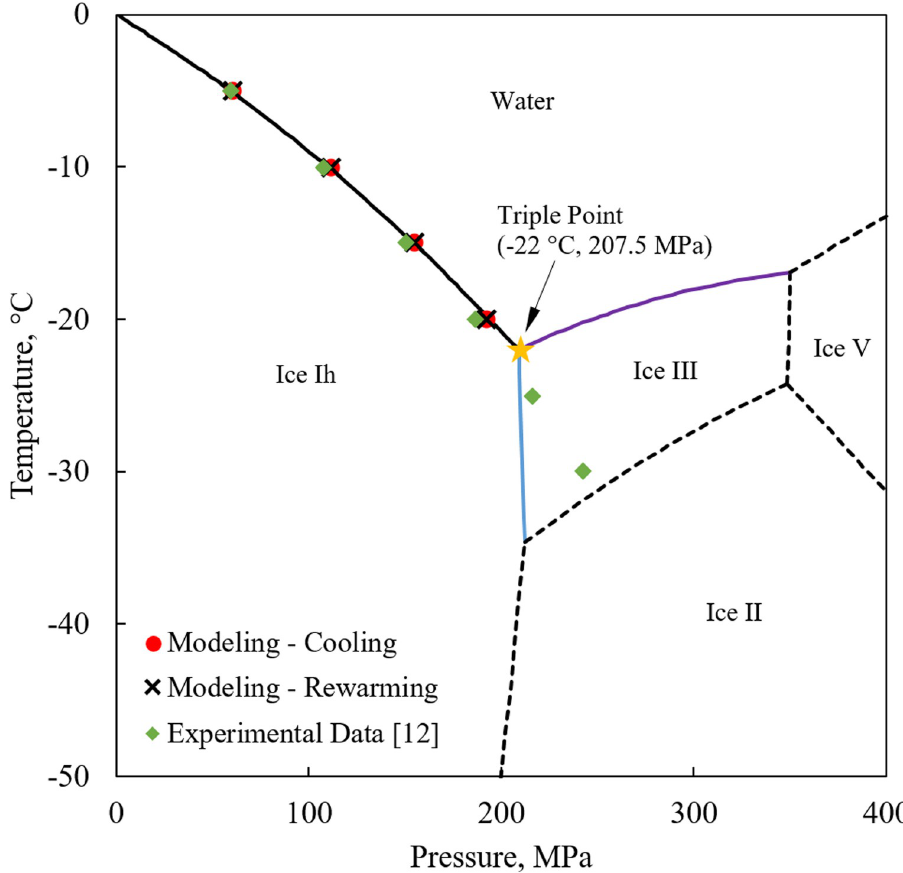
Fig 1. Water phase diagram. Phase diagram of water in temperature and pressure ranges relevant to the current study, as compiled from [11]. Also displayed are experimental results reported in the literature [12] and modeling results developed in the current study for similar